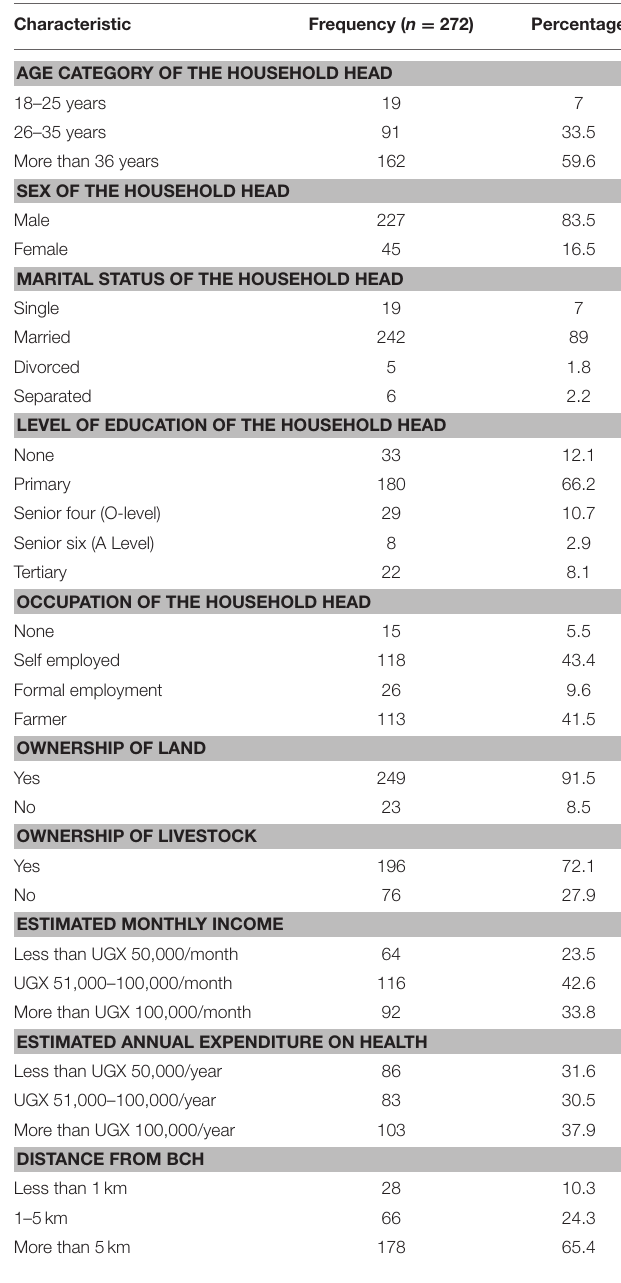
TABLE 2 | Characteristics of the